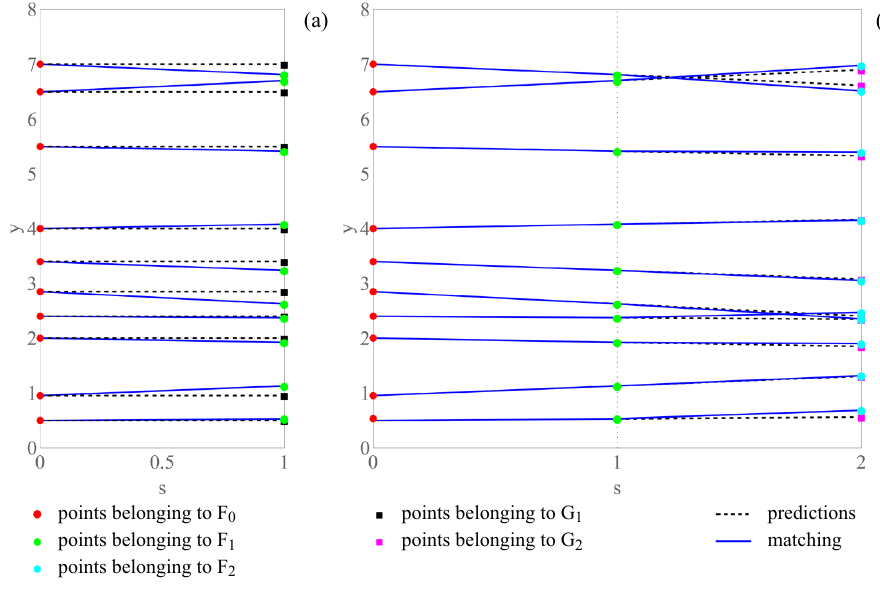
Figure 6. Algorithm 1: (i) First iteration; (ii) Second